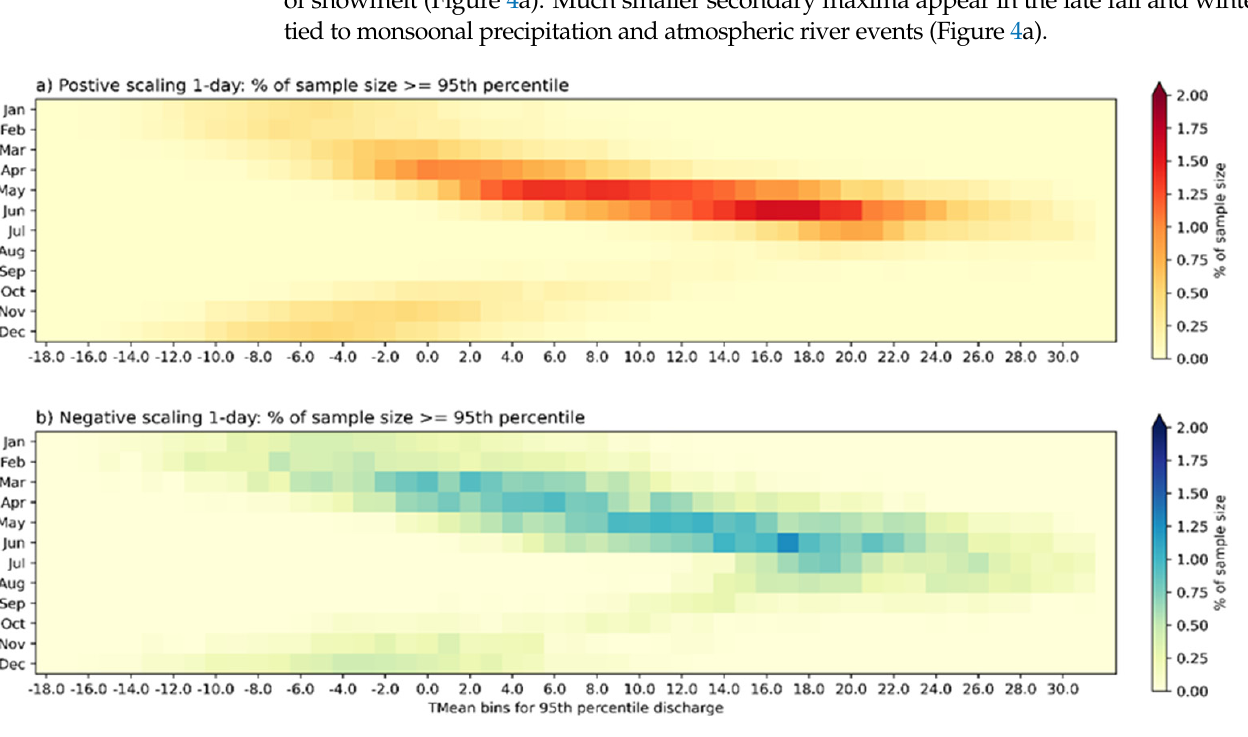
Figure 4. Monthly distribution of sample size of scaling by PRISM daily mean temperature with at least 95th percentile of discharge ( a ) for positive scaling with discharge and ( b ) negative scaling with discharge.